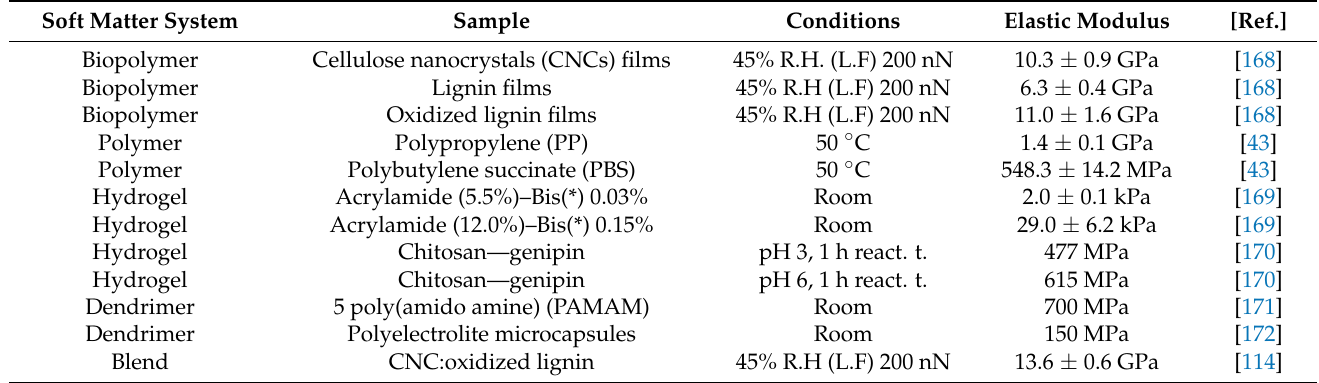
Table 3. Elastic modulus of illustrative soft matter samples measured recently by AFM. Samples are sorted by alphabetical order and classified inside the soft matter system they belong. (*) Bis = bis- acrylamide. Room conditions refer those AFM measurements conducted in air at environmental temperature and relative humidity